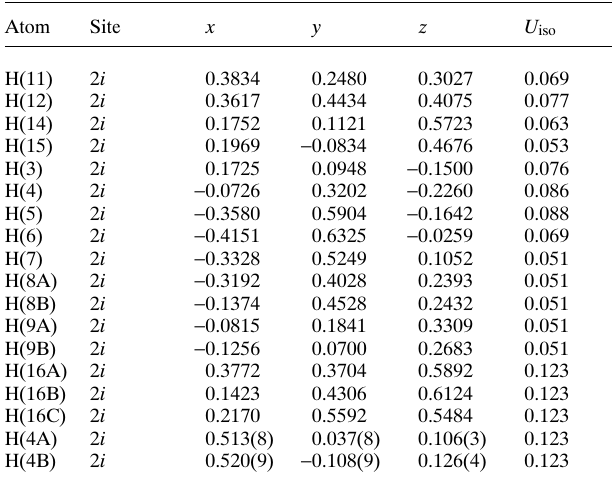
Table 2. Atomic coordinates and displacement parameters (in Å 2 ) .